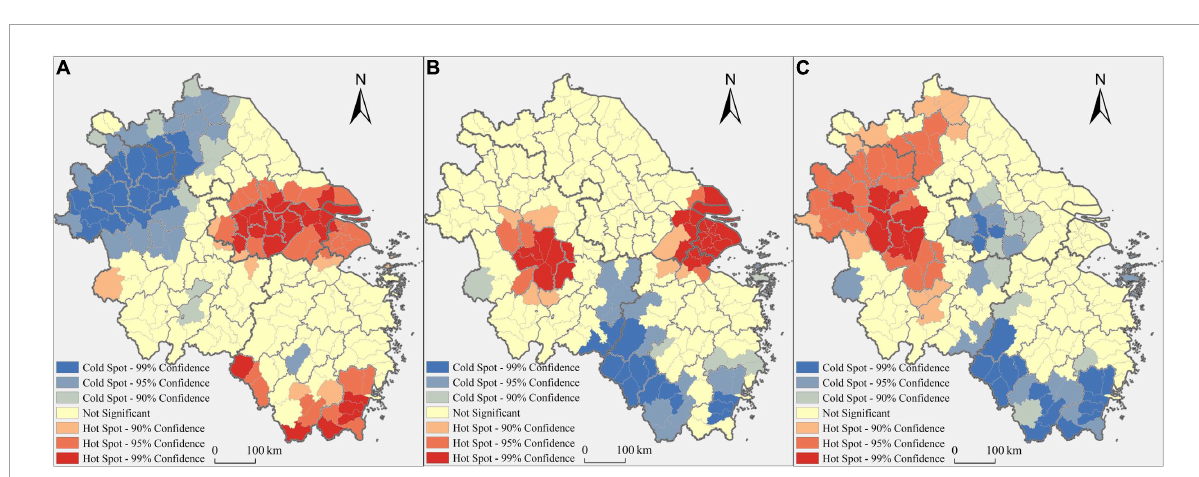
FIGURE5 The spatial clusters of CLUE changes in the YRD from 2000 to 2020. (A) During 2000–2010. (B) During 2010–2020. (C) Annual changing differentials between the two periods.